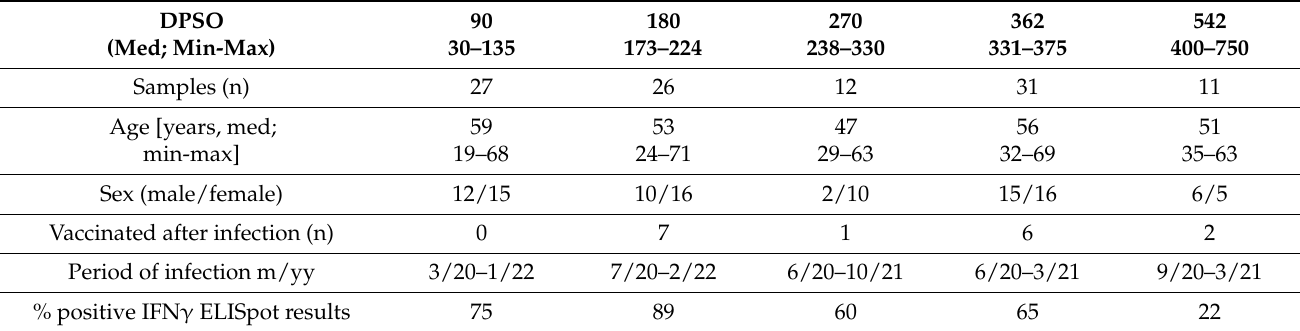
Table A1. Characteristics of 95 donors included in the study.